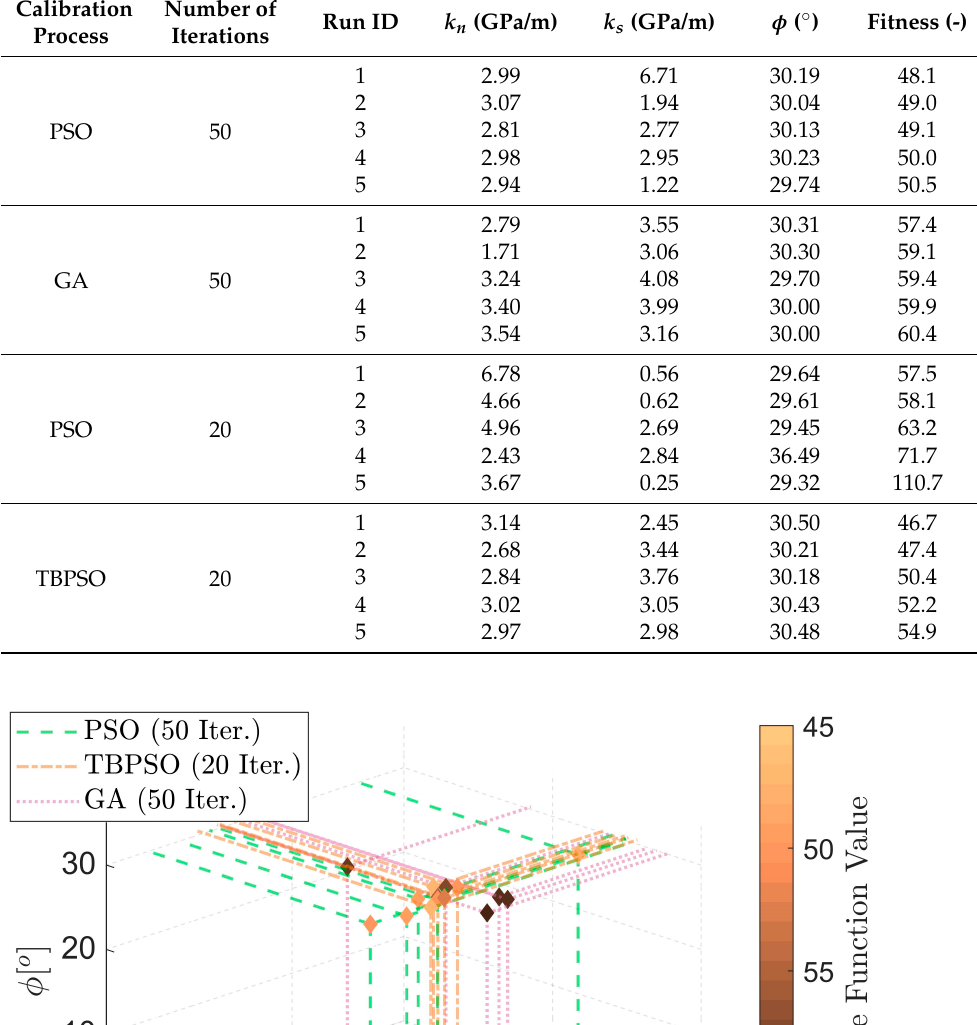
Table 4. Five best solution sets for objective function 2 of densely meshed geometry.